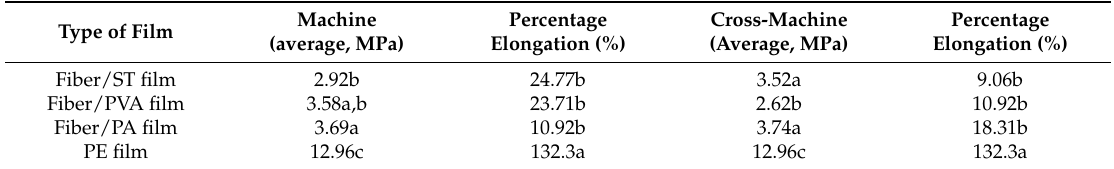
Table 1. Tensile strength at break of the different mulching films. ST: Starch; PVA: Poly(vinyl alcohol); PA: Polyacrylate; PE: Polyethylene a .